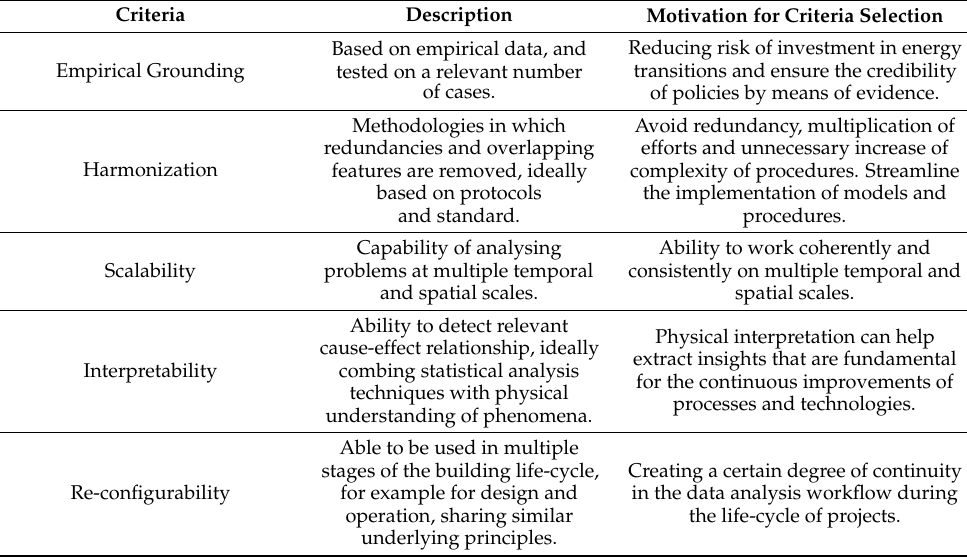
Table 2. Additional criteria introduced for energy modelling literature selection.